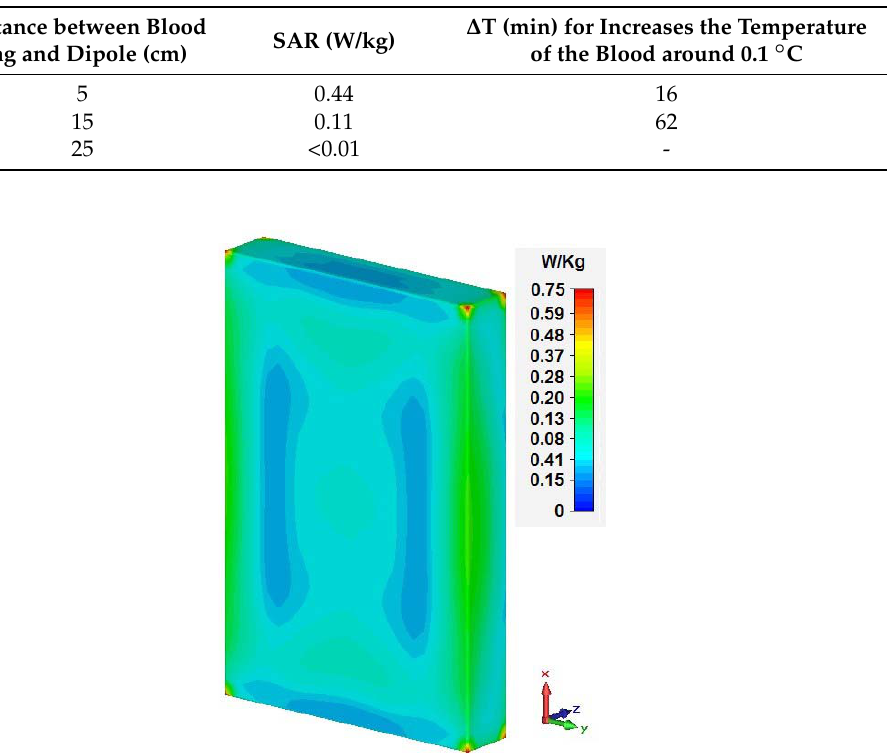
Figure 9. SAR distribution for plane wave at the frequency of 867 MHz on blood bag parallelepiped rounded wedges.